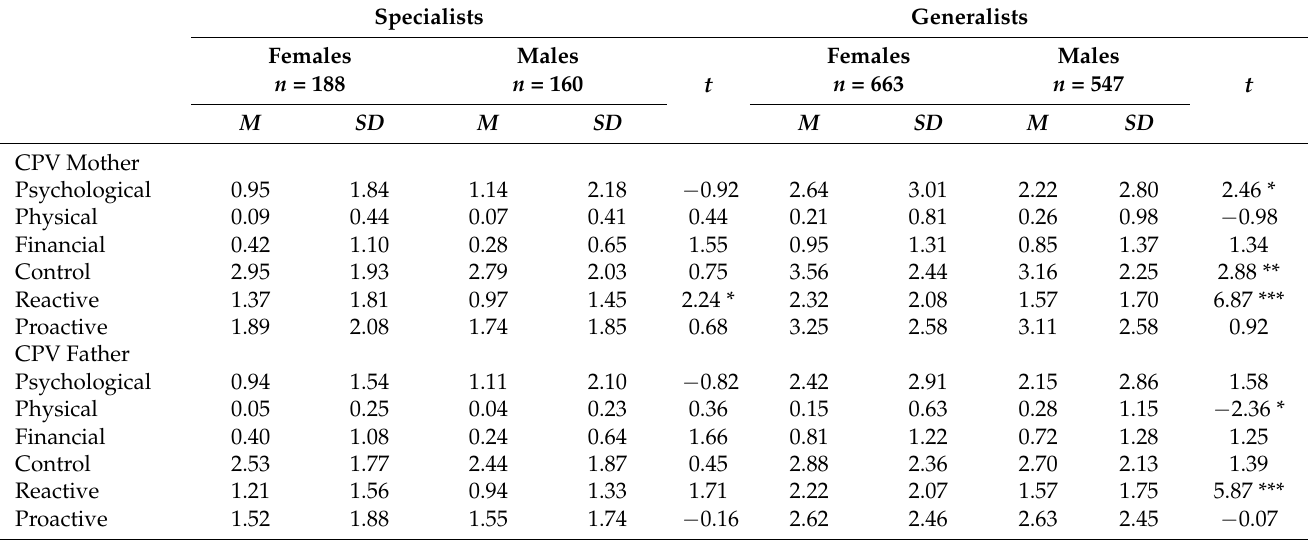
Table 1. Gender differences in child-to-parent violence pattern by aggressor type.